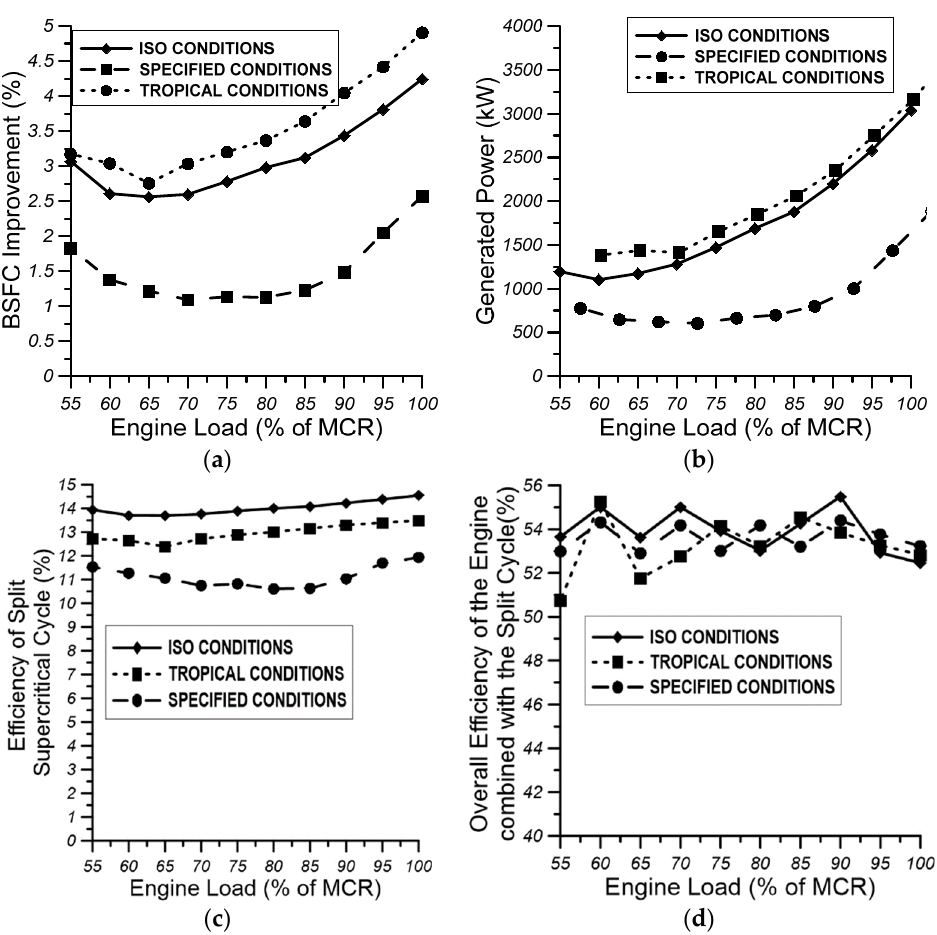
Figure 10. Variation of ( a ) BSFC improvement, ( b ) generated power, ( c ) efficiency of the split supercritical cycle, ( d ) overall efficiency of the engine combined with the split cycle with engine load for ISO, tropical, and specified conditions.